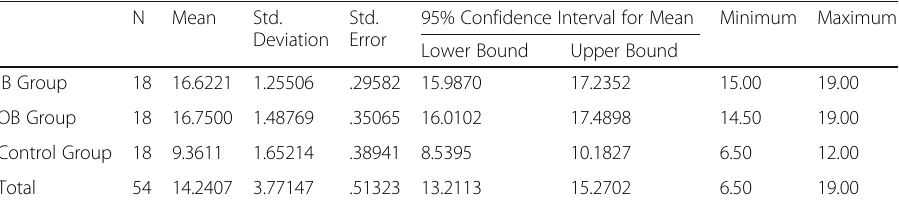
Table 4 Descriptive Statistics (Post-Tests)